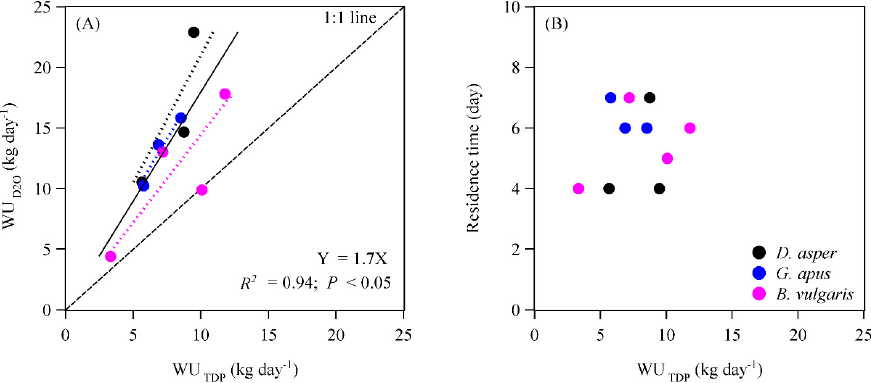
Figure 3. ( A ) Water use of the bamboo species B. vulgaris , G. apus, and D. asper estimated by the TDP method (WU TDP , kg day − 1 ) versus water use determined by deuterium tracing (WU D2O , kg day − 1 ). The solid line represents the regression for the pooled values of all three species, dotted lines are species-specific regressions and the 1:1 line appears dashed. ( B ) Residence time (days) of deuterium in transpired water versus WU TDP .